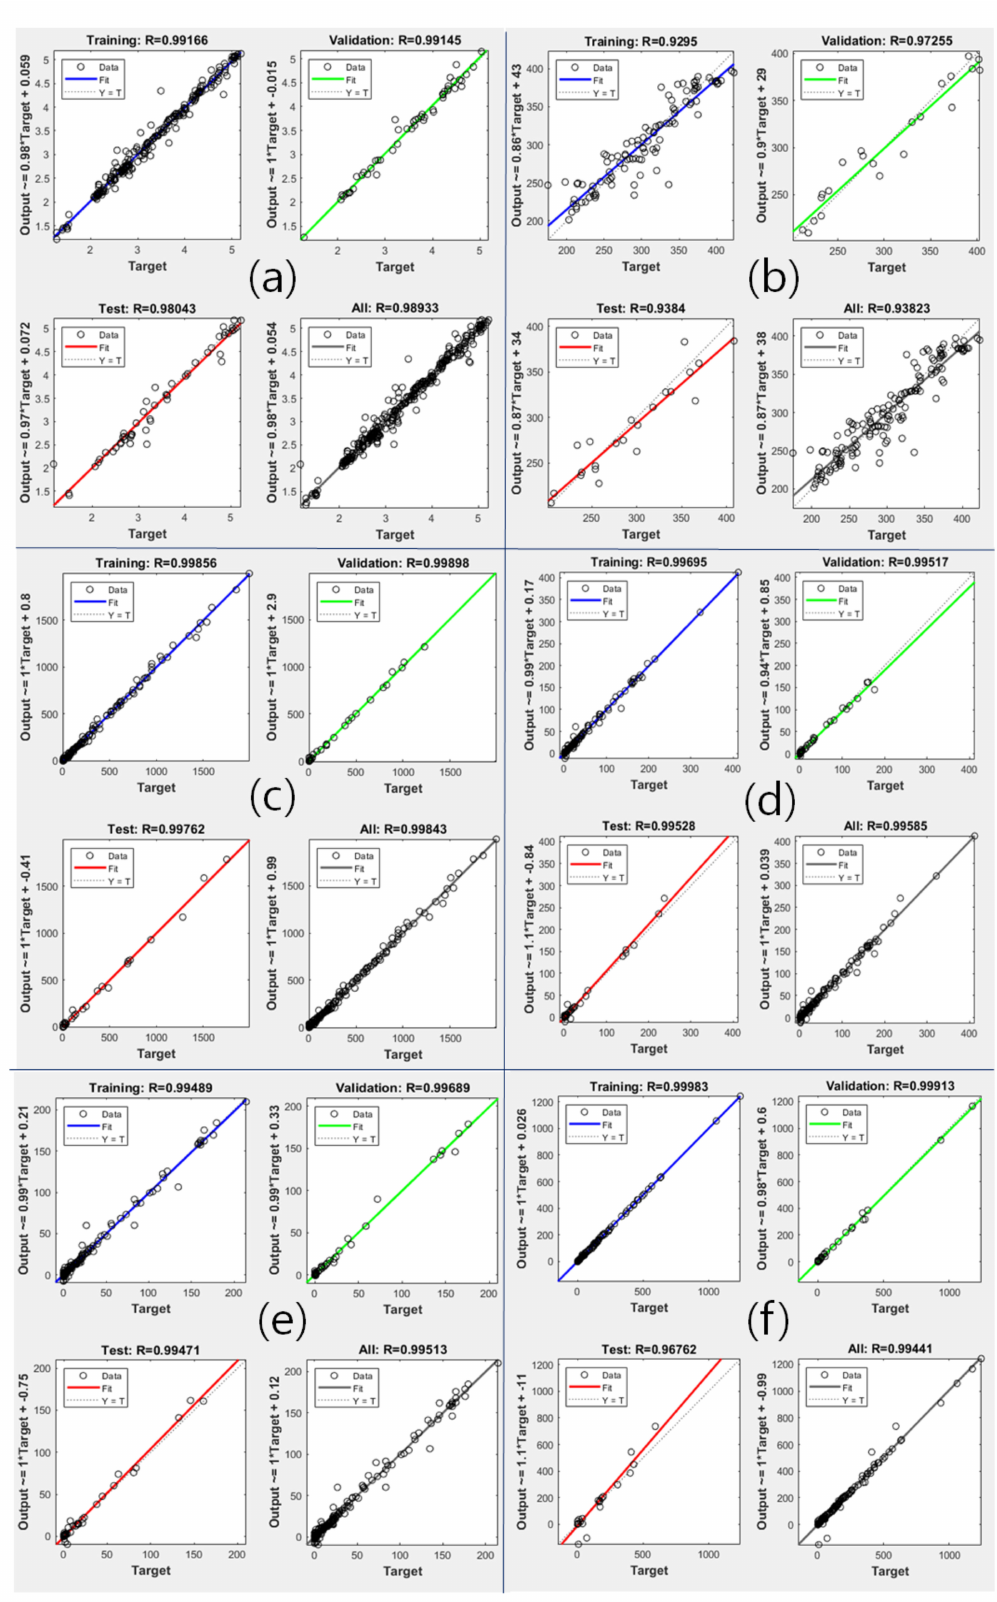
Figure 2. Diagnostic plots between observed and predicted values in the ANN model with each output variable’s best topology: ( a ) pH; ( b ) Eh; ( c ) Cu concentration; ( d ) Pb concentration; ( e ) Zn concentration; and ( f ) Fe